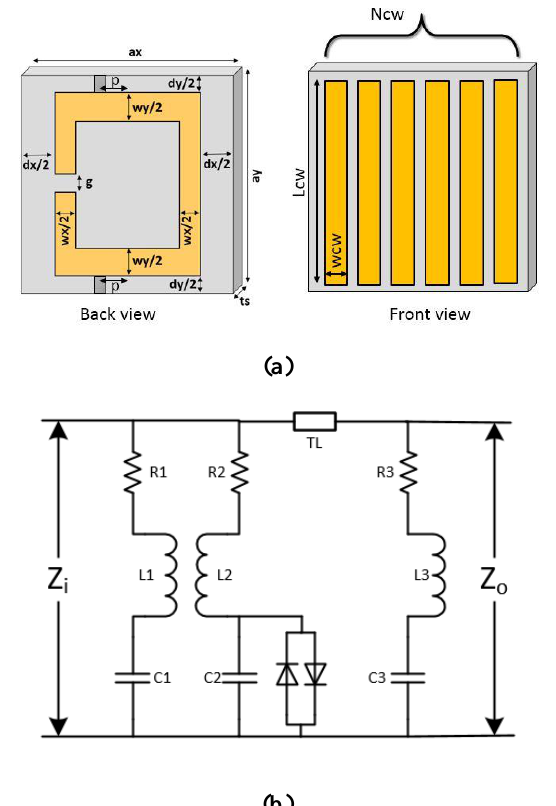
Figure 1: Parametric view of unit cell (a). The front view is shifted up half a unit cell relative to the back view and parameter “P” is the position of diodes relative to middle of the unit cell. TL-RLC model of eSRR-CW structure loaded with diode (b) [23].